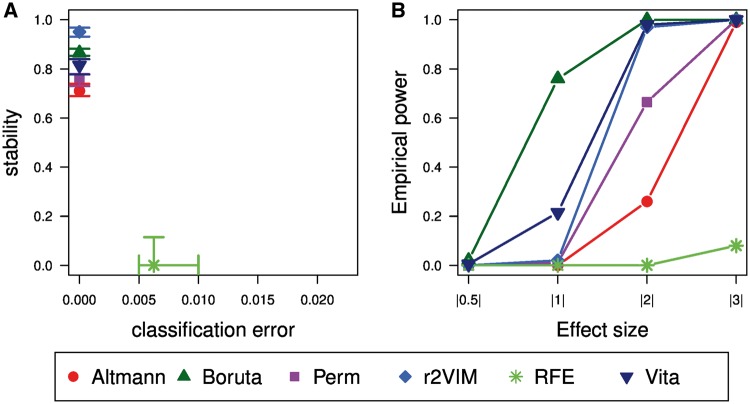
Performance comparison in Simulation Study 2. Shown are classification error versus stability (A) and empirical power depending on the absolute effect size (B). For classification error and stability the median as well as the interquartile range over all 50 pairs of replicates are displayed. For empirical power the median frequency per category of absolute effect size is given. Results for each method can be distinguished by plotting symbols and colors.